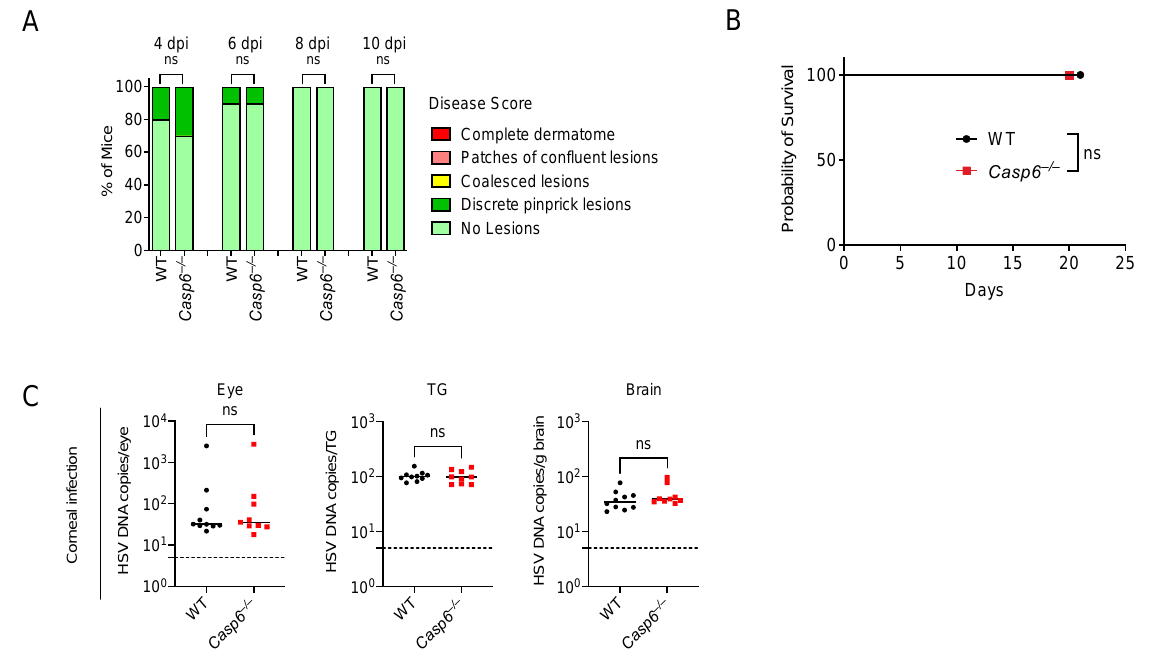
Figure 3. Caspase-6 is dispensable to control HSV-1 ∆ Us3 infection. ( A , B ) WT ( n = 10) and Casp6 –/– ( n = 10) mice were infected with 10 6 HSV-1 ∆ Us3 strain via skin inoculation. Disease scores ( A ) and survival ( B ) were monitored daily between WT and Casp6 –/– mice. ( C ) WT ( n = 10) and Casp6 –/– ( n = 9) mice were infected with 10 6 HSV-1 ∆ Us3 strain via ocular inoculation. HSV-1 DNA copies were determined in the eye, TG, and brain of WT and Casp6 –/– mice at 4 dpi by qPCR. Data are pooled from two experiments ( A – C ). Dashed lines indicate detection limit. ns: not significant.